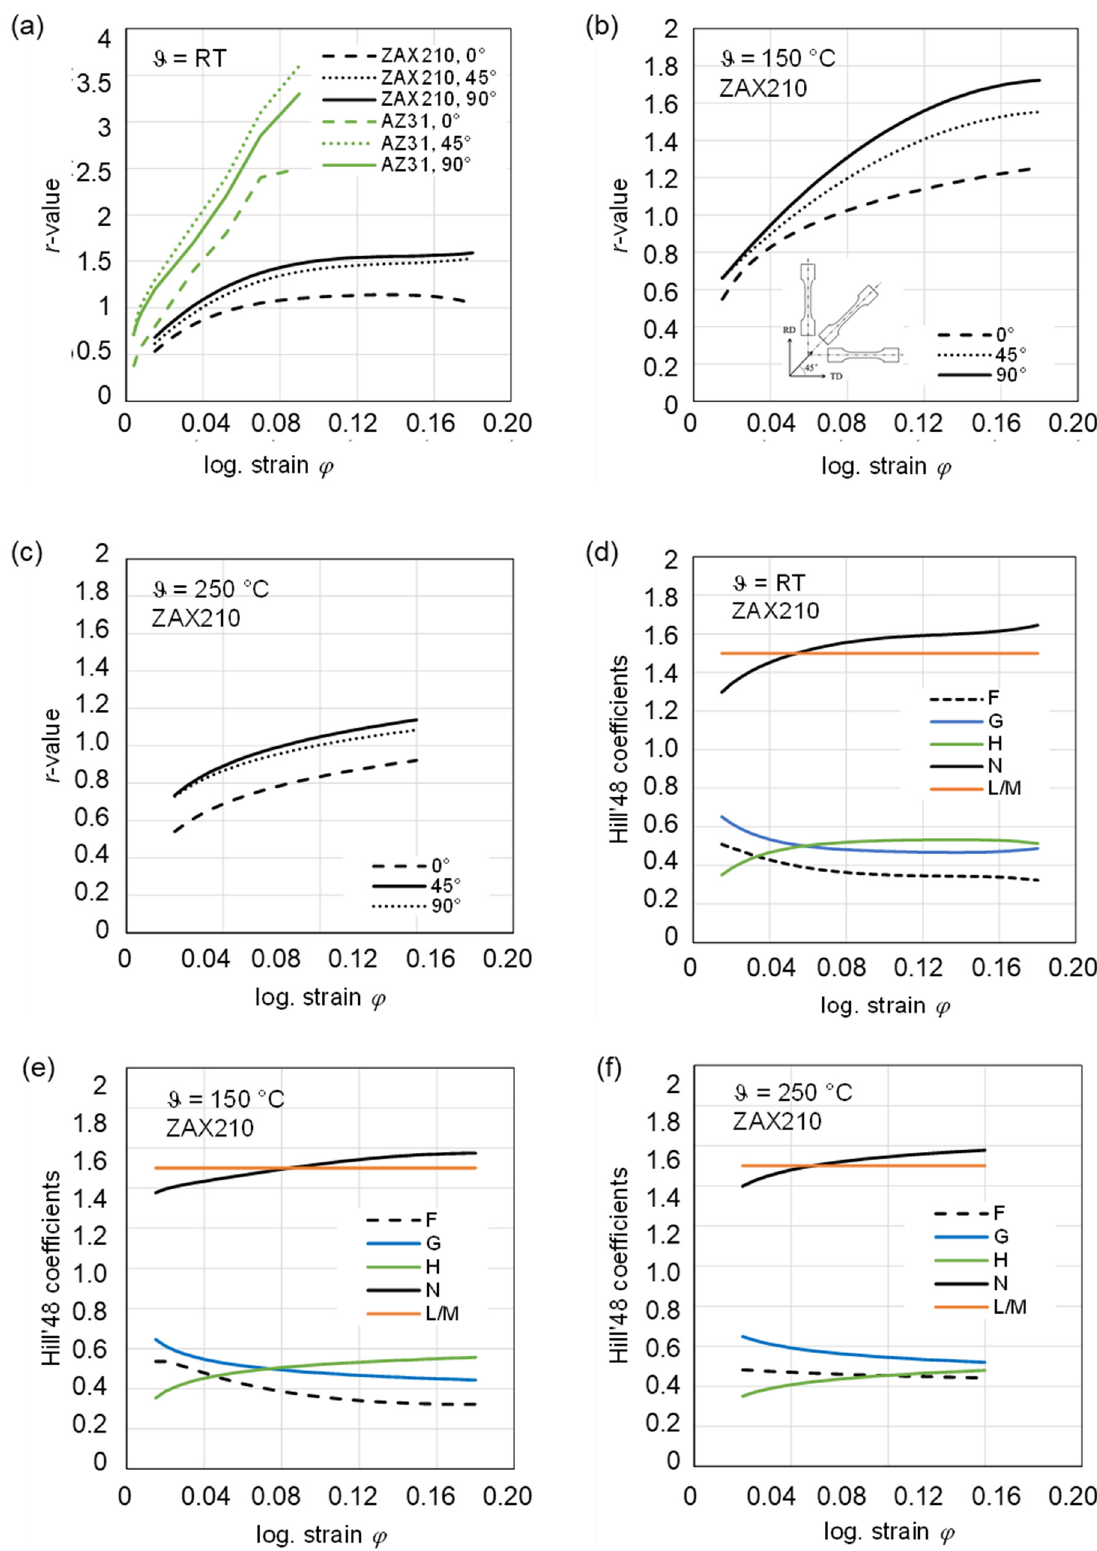
Figure 5. Variation in r -values with log. strain used to determine the material parameters for the anisotropic yield functions and Hill’48 coefficients: ( a ) ZAX210 in comparison with AZ31 (data from [24]) at RT, ( b ) ZAX210 at 150 °C, ( c ) ZAX210 at 250 °C, ( d ) Hill’48 coefficients for ZAX210 at RT, ( e ) Hill’48 coefficients for ZAX210 at 150 °C and ( f ) Hill’48 coefficients for ZAX210 at 250 °C.